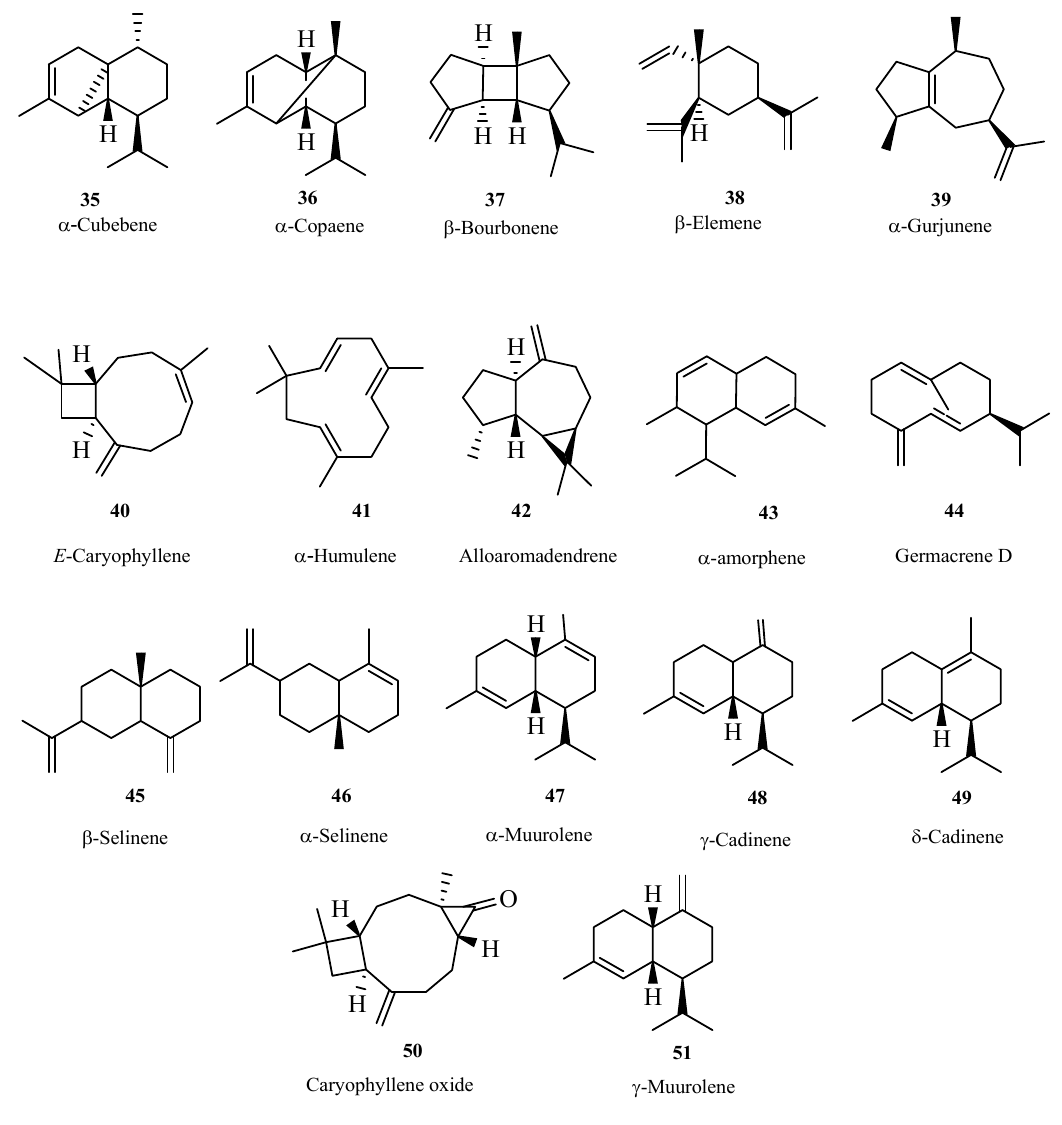
Figure 2 . Sesquiterpenes from the essential oil of the Boswellia sacra